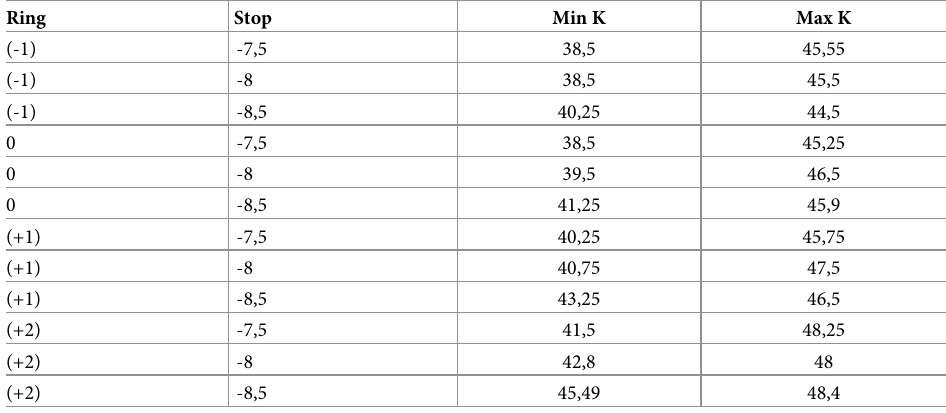
Table 5. Multivariance logistic regression for keratometries, rings, stops and CCT of the training data